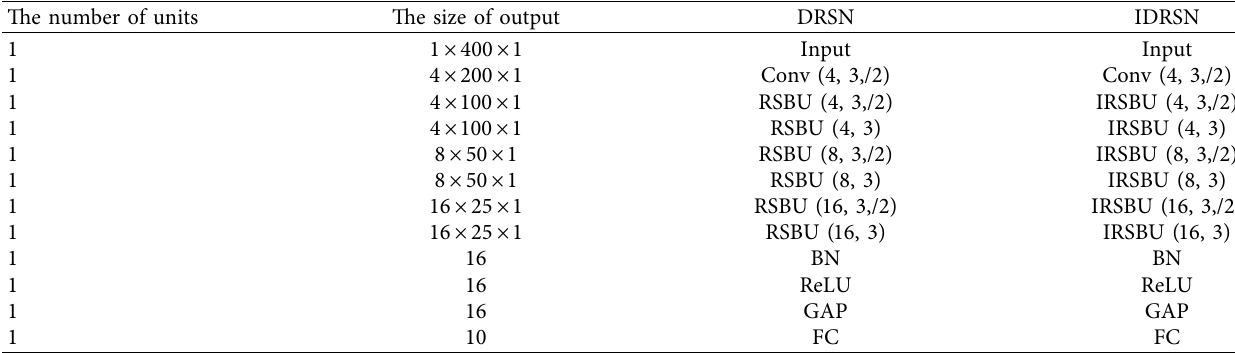
Table 2: Experiment-related hyperparameters of DRSN and